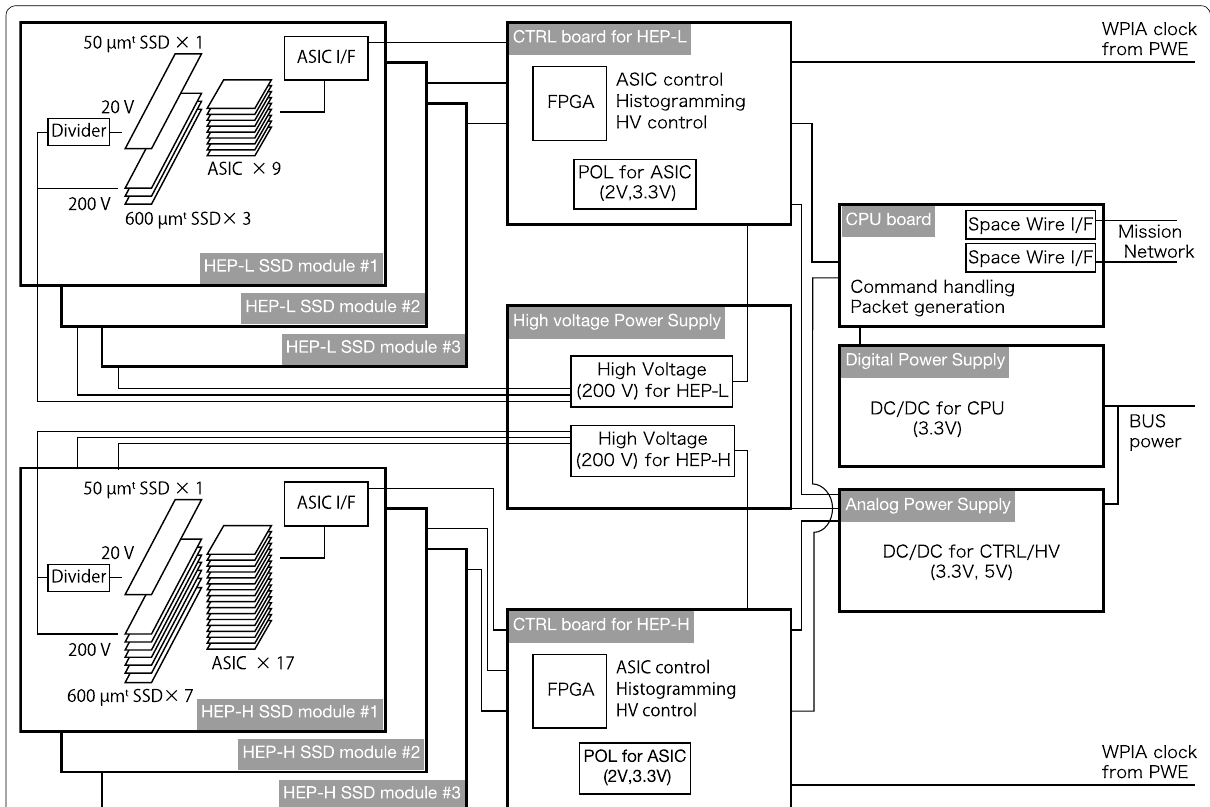
Fig. 4 Functional block diagram of HEP instrument. The three HEP-L and HEP-H SSD modules are controlled independently by two control boards. A central processing unit (CPU) board receives command packets and sends telemetry data to the mission network. The CPU board collects histogram data from the control boards in addition to instrument-status data. The bias voltage of the SSDs is supplied from a high-voltage–power supply board that includes two independent high-voltage DC–DC convertors, with the power and reference voltage controlled by the control